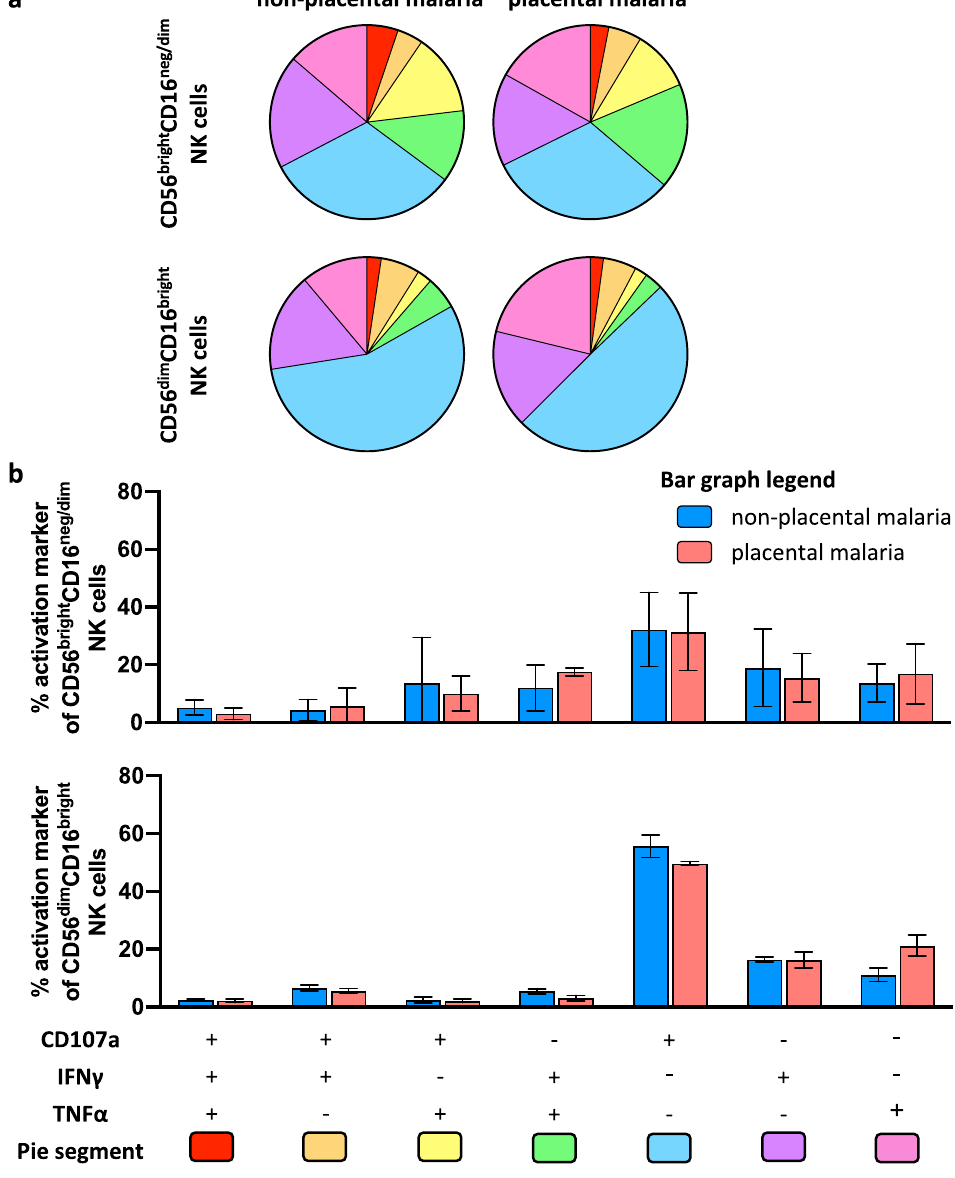
Figure 5. Polyfunctional responses of NK cells induced by DBL3-specific Abs from pregnant women with malaria. NK cells from three separate donors were stimulated with IgG from pregnant women mid pregnancy with non-placental malaria (N = 27), women with placental malaria (N = 50) at delivery in presence of DBL2 and assessed for expression of CD107a, IFNγ and TNFα. NK cells were selected based on their CD56 expression (CD56 dim and CD56 bright ). Pie and Bar charts show the proportion ( a ) and relative frequency ( b ) of each activation marker combination of only activated NK cells. ( a ) The pie segments correspond to NK cells expressing different combinations of activation markers and are color coded (pie segment legend: pink- red) to indicate increasing polyfunctional NK cell activation. ( b ) The bar graph shows relative frequencies of combinations of activation markers by NK cells stimulated with IgG from non-placental malaria-infected women (blue) or women with placental malaria (red) in presence of DBL3 (bottom bar graph). Mean of three NK cell donors with standard deviation is shown. Statistical analysis between groups was performed using multiple t tests corrected for multiple comparisons using the Holm-Šídák